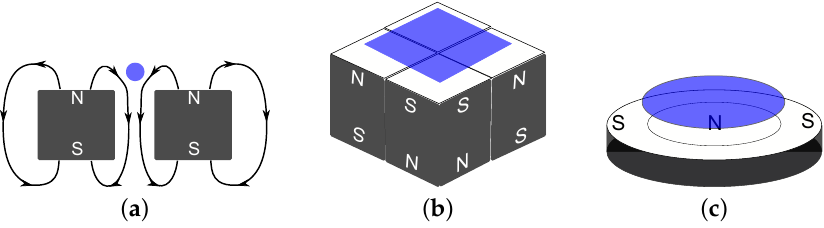
Figure 5. Diamagnetic levitation micro-actuators: ( a ) two magnet design for levitation of droplet/particle [61,62,65,66]; ( b ) four magnet design for levitation of a plate [67,68]; ( c ) the design with a ring and disc shaped magnets